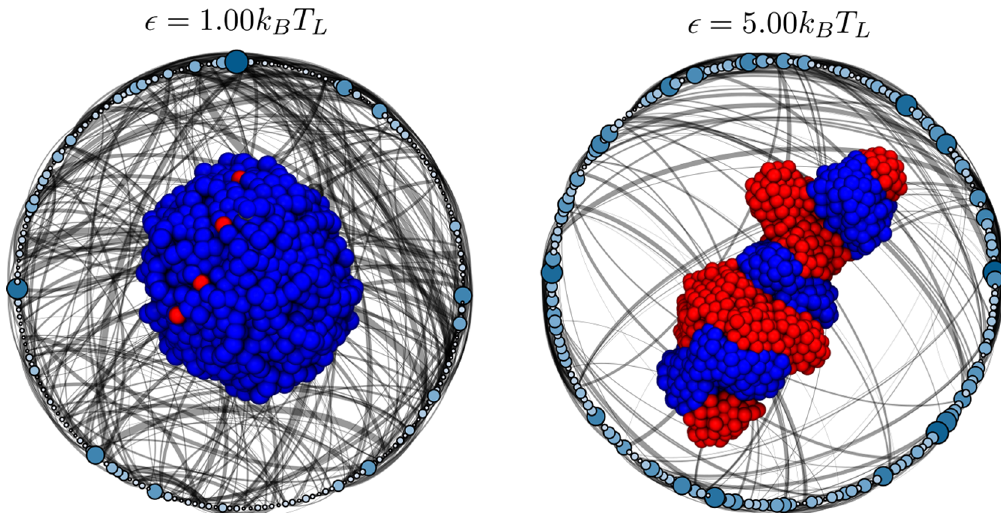
FIG. 5. The network of interactions is short-ranged for fast-collapsing coils. We show a snapshot of the network of bead-bead contacts T T taken at t ¼ 10 6 τ for two simulations with (left diagram) ϵ ¼ 1 k and (right diagram) ϵ ¼ 5 k . For clarity of visualization, each B L B L Br node of the network coarse grains 10 beads along the chain. The node size and color intensity encode the number of interactions within the coarse-grained monomers. Edges are only drawn between nodes that contain interacting monomers, and their thickness is proportional to the (normalized) number of contacts. To improve the visualization, only edges corresponding to contact probabilities between monomers in the top 30% are displayed. Snapshots of the respective 3D conformations are also shown. It is important to notice that higher values of α lead to short-ranged networks, which translates into fewer edges but larger nodes in this coarse-grained